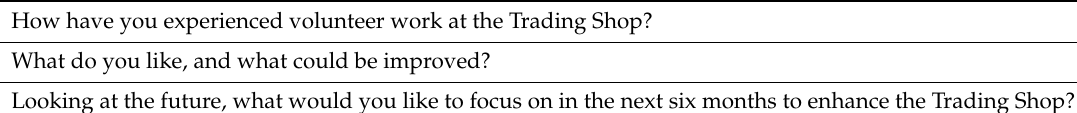
Table 4. Interview guide group